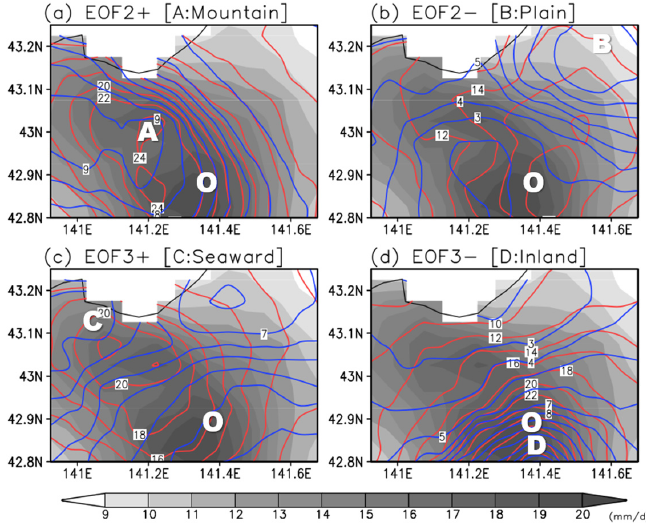
Figure 13. Average precipitation (grey shade) for EOF1 (score > 1) overlaid by red (blue) contours with average precipitation off each type (A, B, C, D) for EOF1 > 1 (EOF1 < 1).